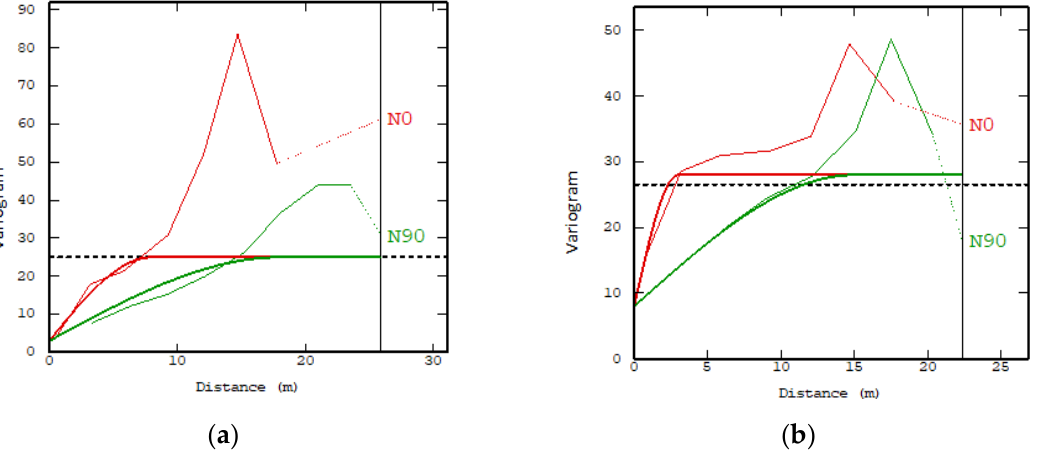
Figure A4. Experimental (thin line) and modeled (thick line) data with anisotropic variograms: ( a ) LGP-3 for ore-A with directions: north: 0° (red) and directions: north: 90° (green); ( b ) LGP-3 for ore-B with directions: north: 0° (red) and directions: north: 90° (green).